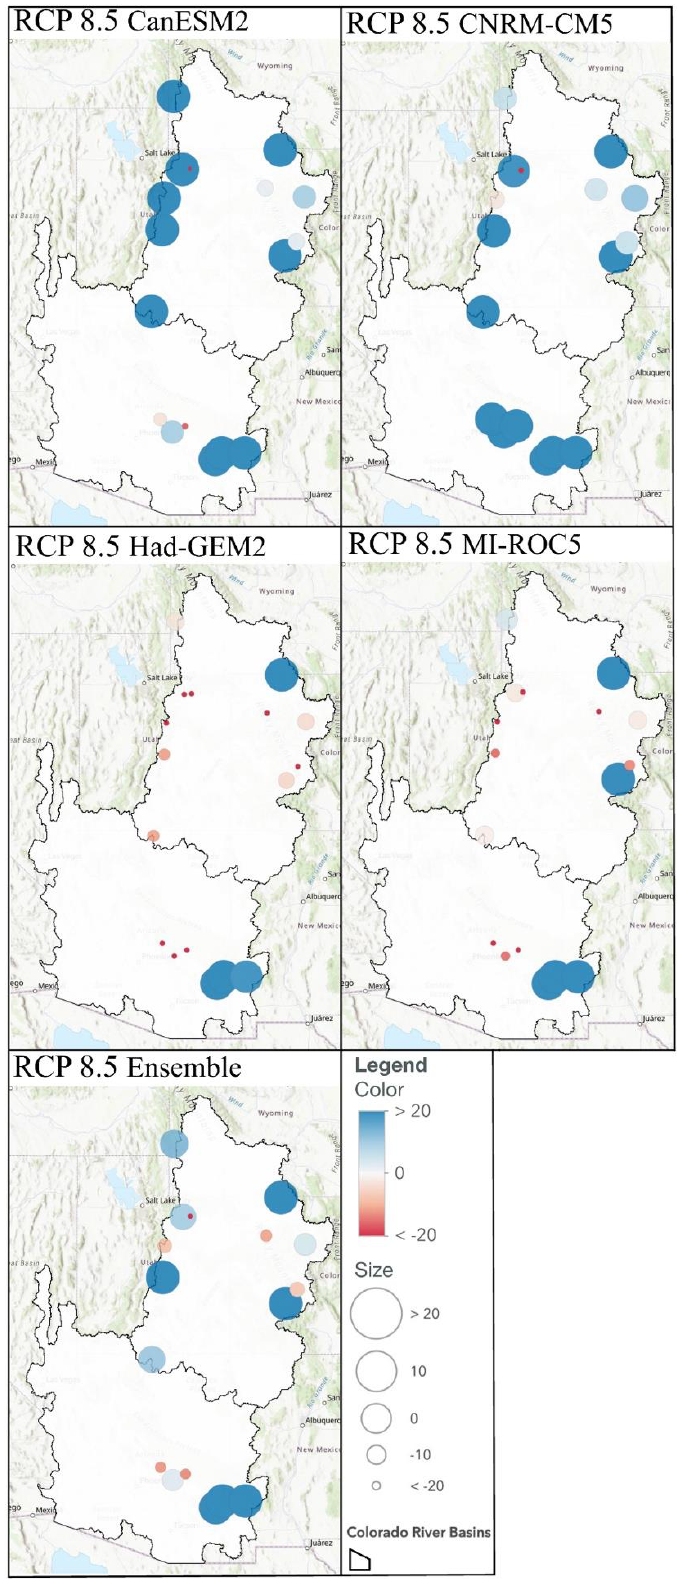
Figure 3. Spatial distribution of percentage change in mean projected water year streamflow for the period 2022 – 2099 for 8.5 RCP scenario, four models and ensemble.